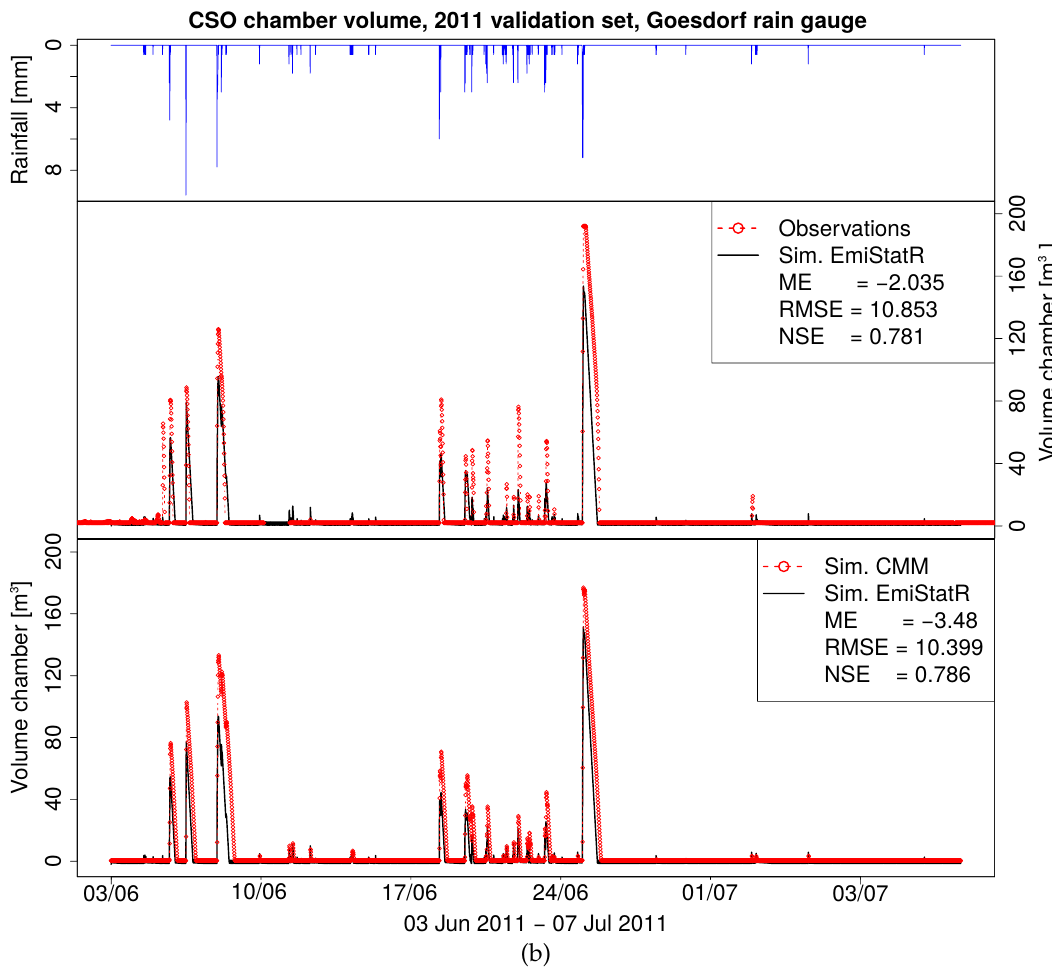
Figure 4. Rainfall and combined sewer overflow chamber (CSOC) volume at Goesdorf. ( a ) Time series of May to June 2011 calibrated with DREAM; ( b ) June to July 2011 simulated time series for validation with observations and the